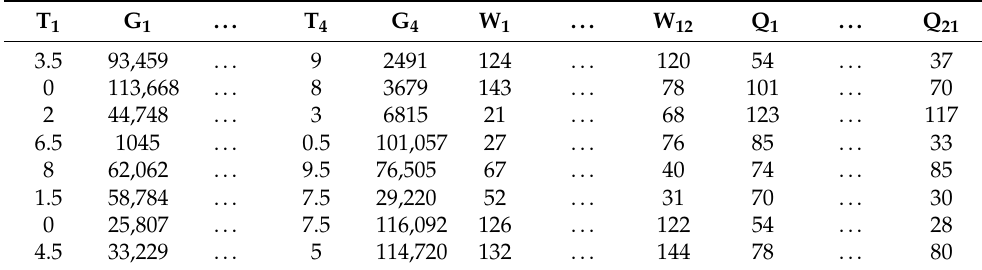
Table 1. Partial injection–production